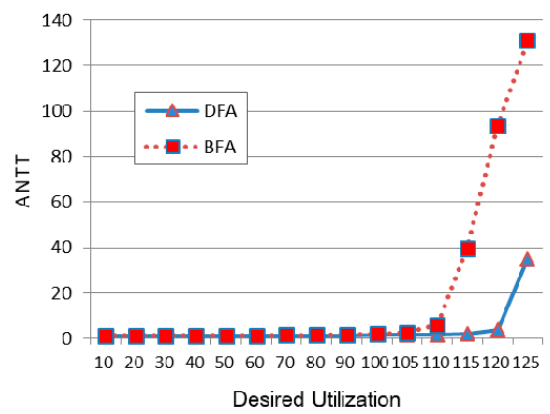
Figure 9. Performance comparison under workloads of extremely biased resource demand.